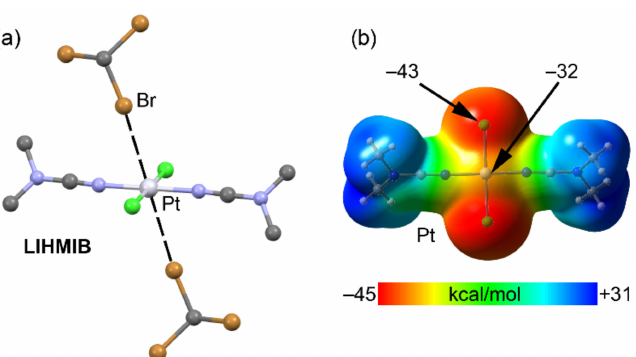
Figure 20. ( a ) Ball-and-stick representation of the X-ray solid-state structure of LIHMEX, in which HaBs are represented as dashed lines. The HaBs are represented using dashed lines. H atoms omitted